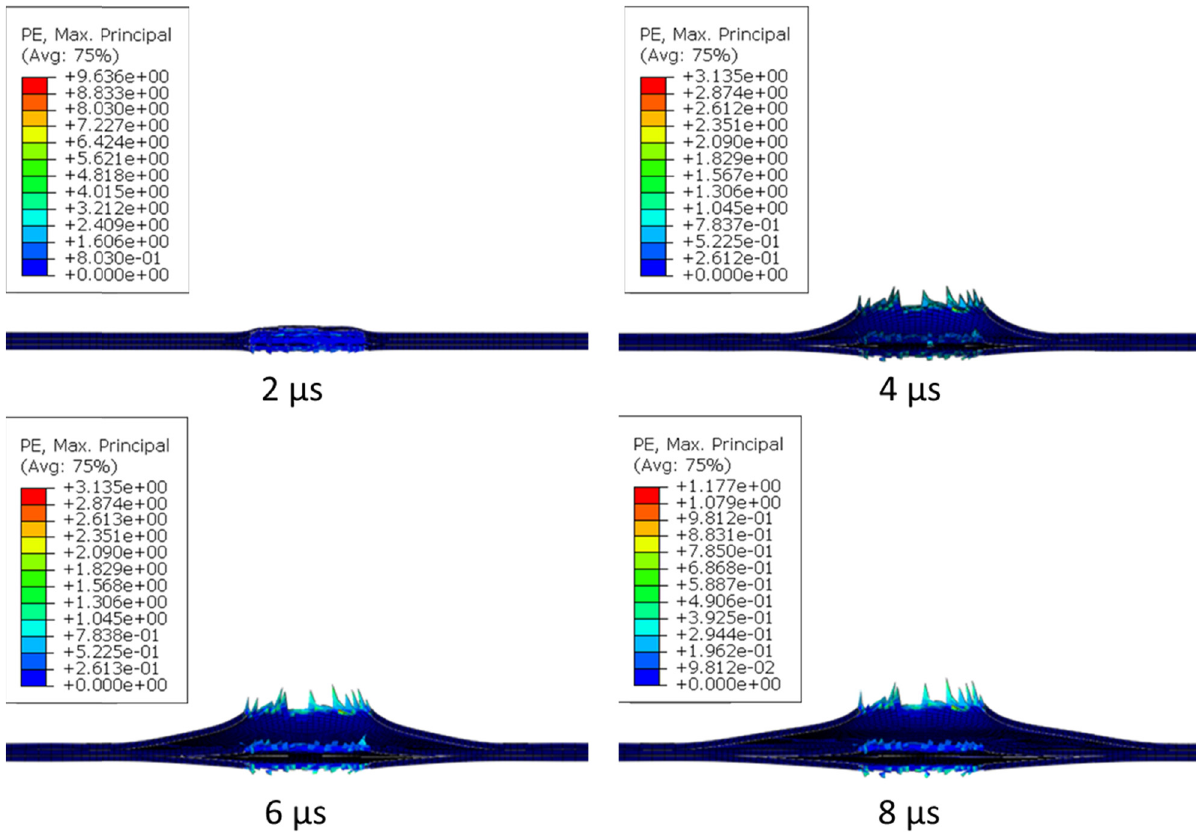
Figure 15: Plastic strain distribution and deformation for model 12 against blunt projectile.